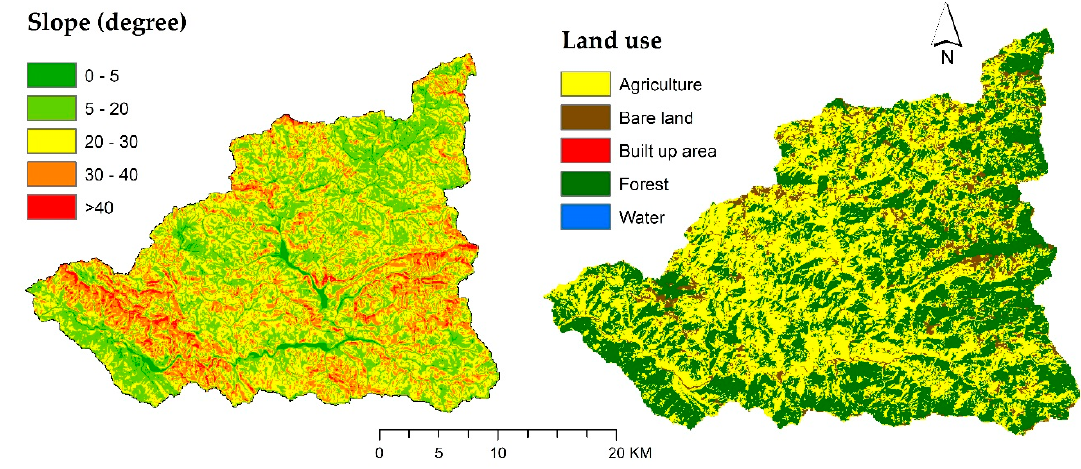
Figure 3. Slope and land use map of the Sarada river basin .